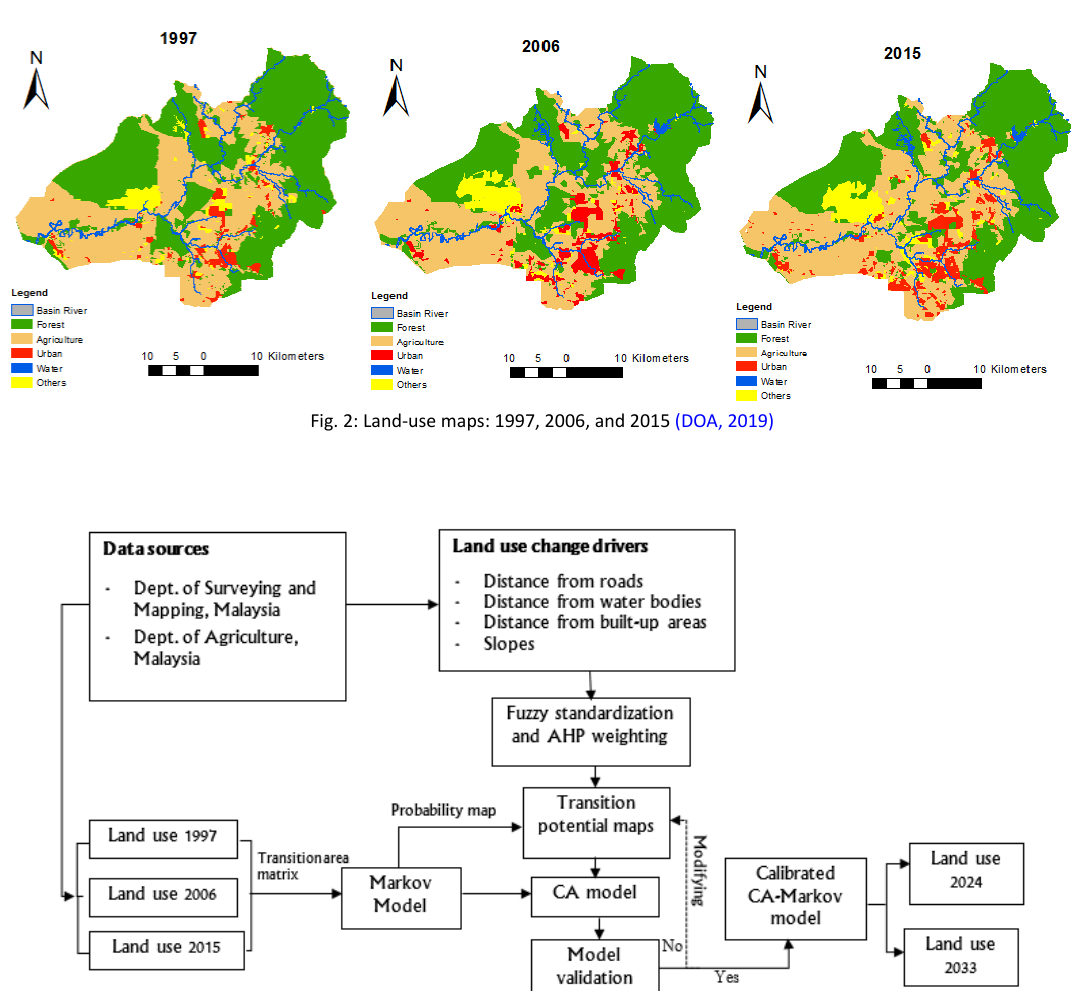
Fig. 3: The method flowchart for predicting land use changes in 2024 and